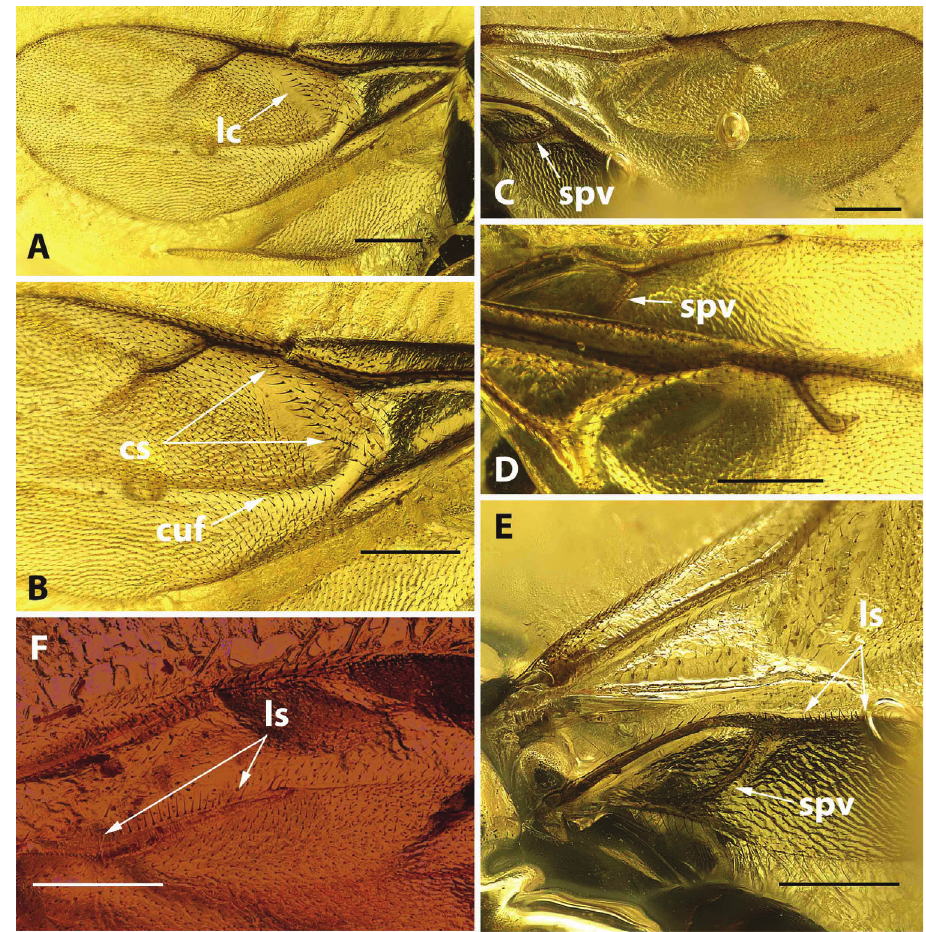
Figure 7. S. glaesaria , females, wings A–E Rovno specimen F holotype from Danish amber A left pair of wings dorsal B forewing venation, dorsal C left pair of wings, ventral D right pair of wings, venation, dorsal E left pair of wings, hind wing venation, ventral F wings venation, ventral. (cs – covering setae, cuf – cubital fold, lc – linea calva, ls – line of setae, spv – spur vein). Scale bars: 0.2